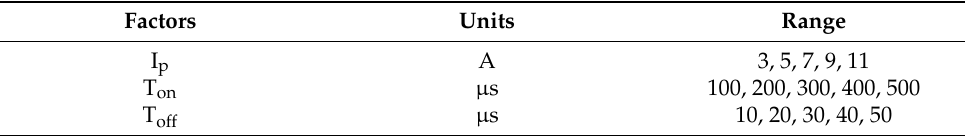
Table 3. Ranges of process